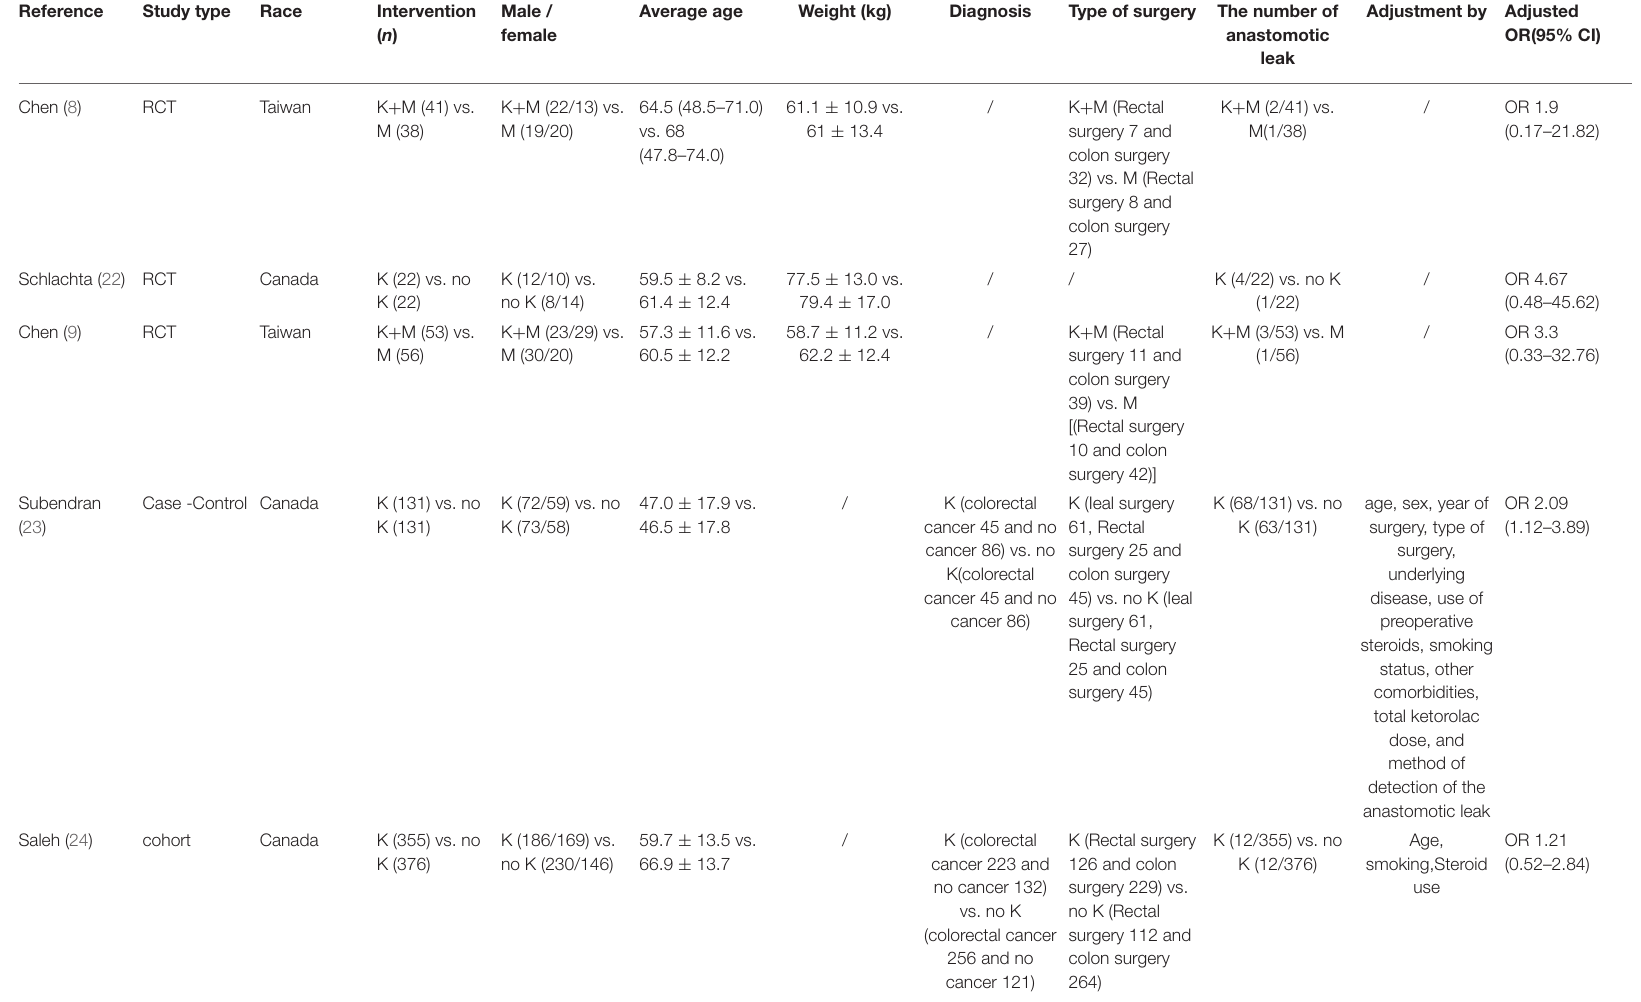
TABLE 1 | Brief characteristics of included